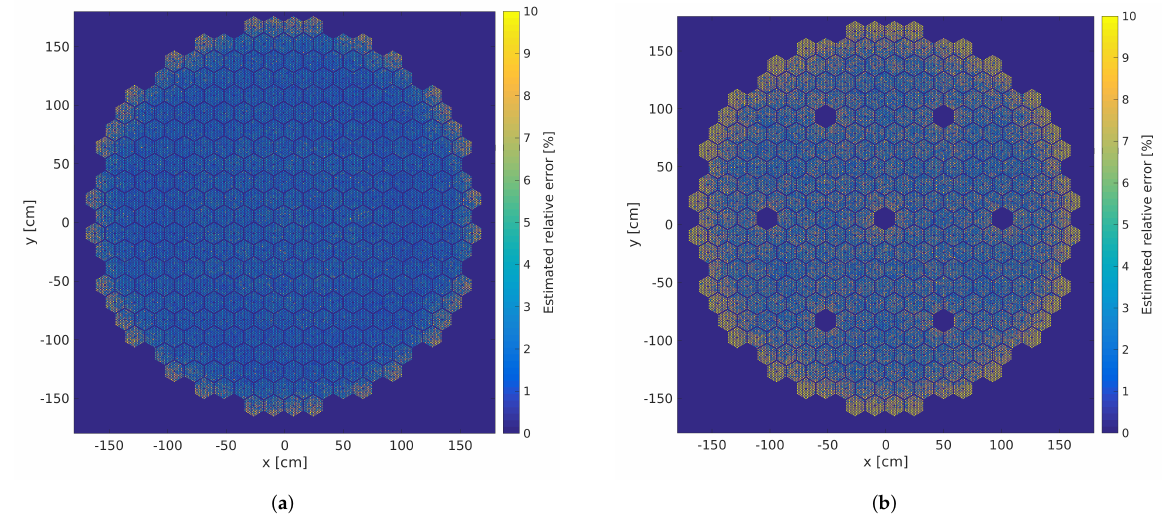
Figure 13. Pin-wise relative error distribution for middle nodes ( a ) and topmost nodes at t = 0 s ( b ).